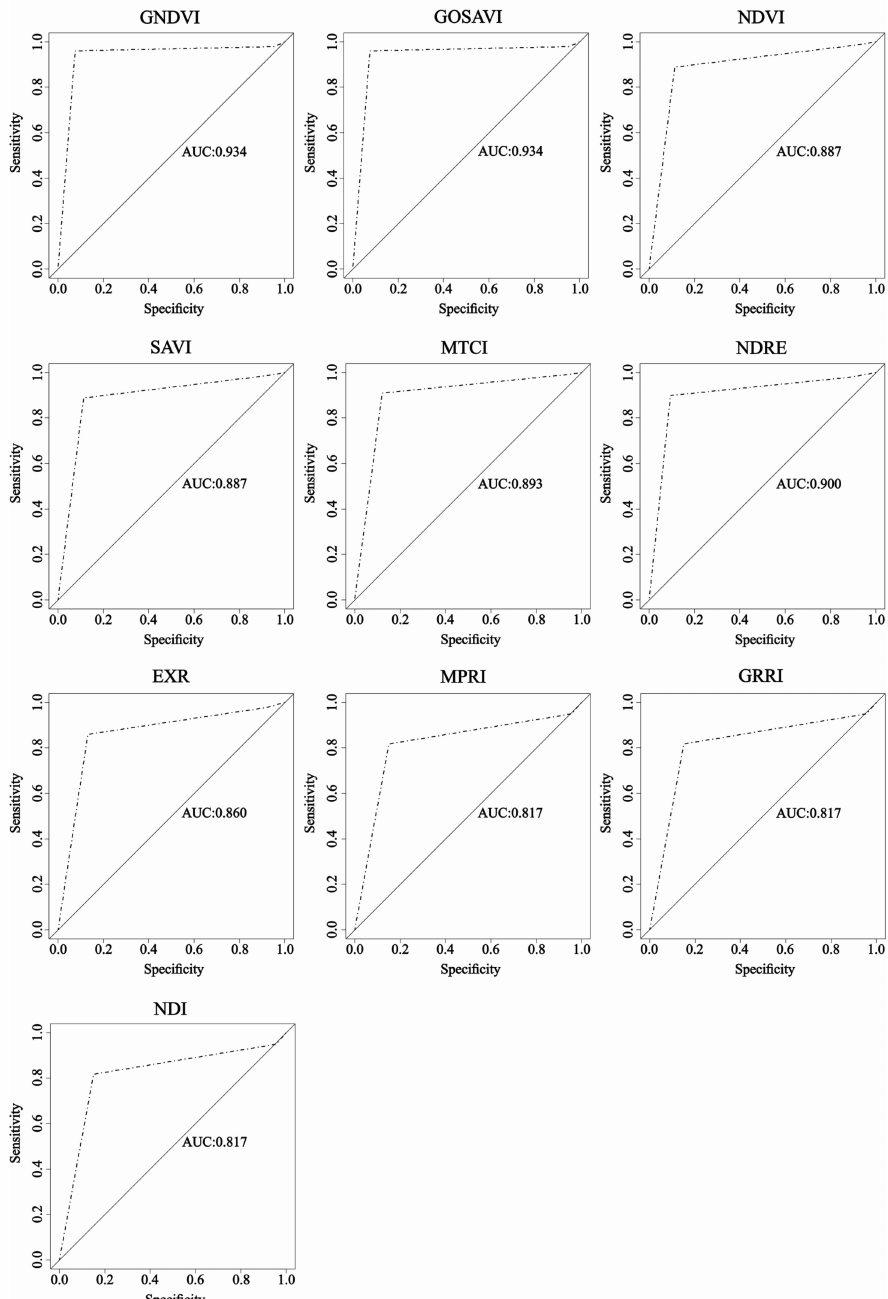
Figure 5. Receiver operating characteristic (ROC) curve and area under the curve (AUC) for image classification through RF from vegetation